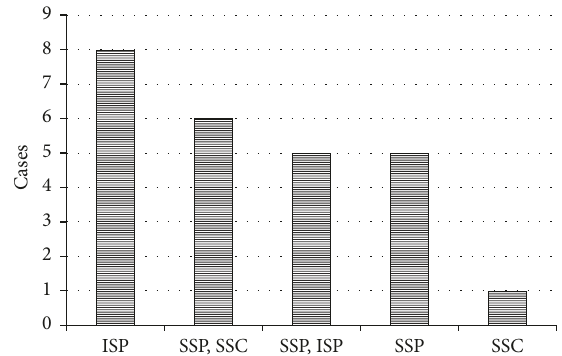
Figure 3: Injured tendon . ISP tendon was injured most frequently, followed by SSP + SSC tendon, SSP + ISP tendon, SSP tendon, and SSC tendon.